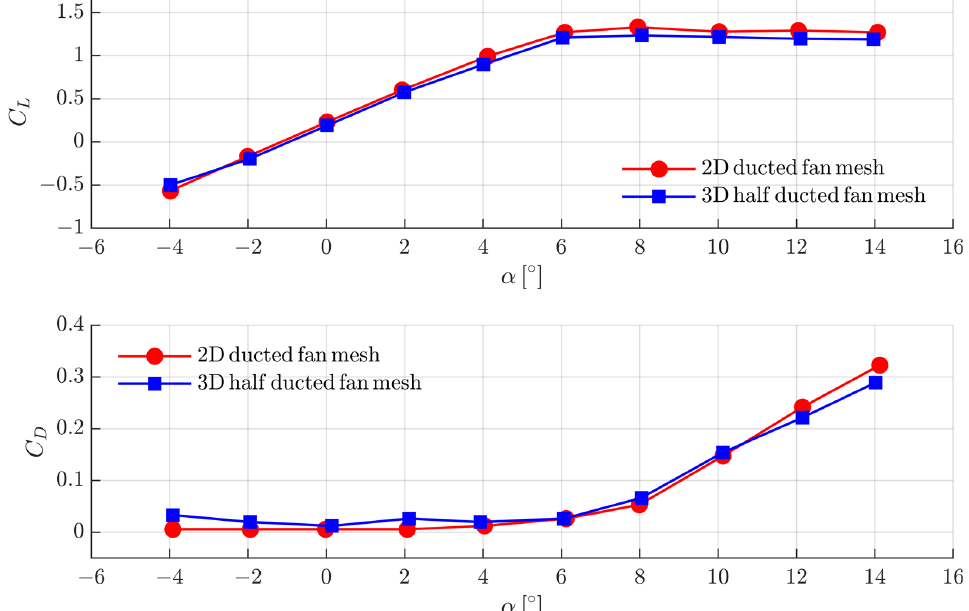
Figure 21. The results comparison between the 2D and half 3D model.